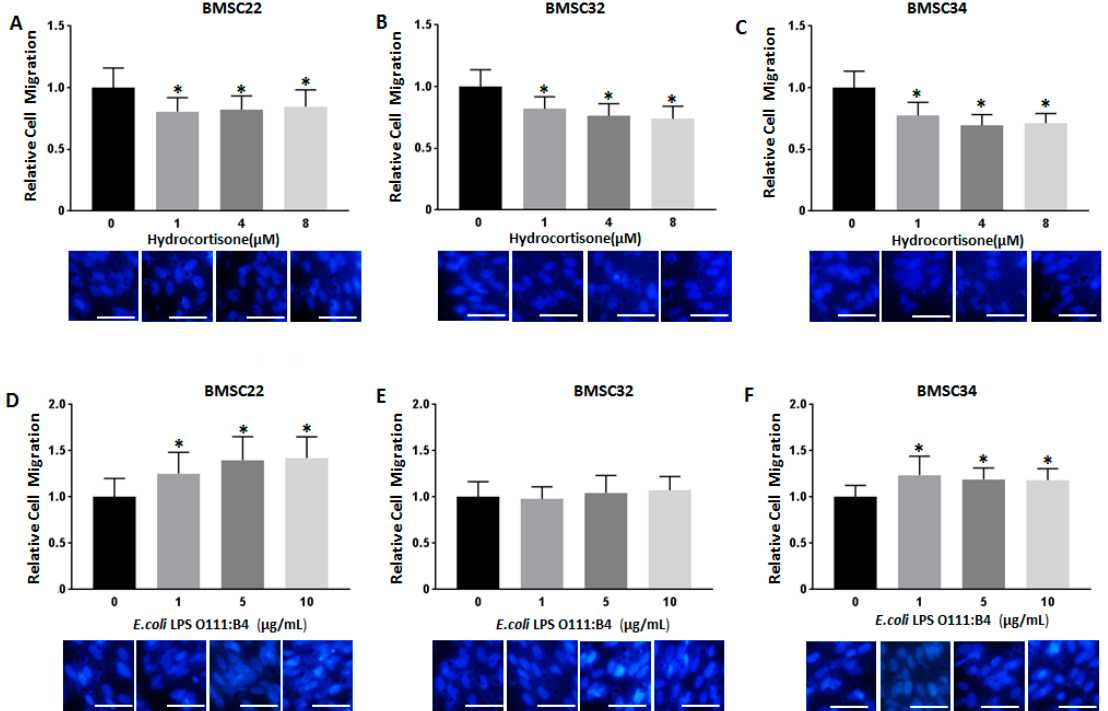
Figure 2. Stimulation with Hydrocortisone or E. coli O111:B4 regulates BMSC migration. The migration capacity of BMSC22, BMSC32 and BMSC34 in presence of Hydrocortisone ( A–C ) or LPS ( D–F ) was evaluated by Transwell Assays. BMSCs were seeded on top of Transwells, and after 24 h the cells that had migrated to the lower chamber were fixed, stained and quantified. Representative images of cells stained with DAPI are depicted below. (Scale bar is 50 µM, Magnification is 40×). * p < 0.05 versus 0 µM Hydrocortisone or 0 µg/mL LPS as determined by one-way ANOVA. 3.3. The Immunosuppressive Capacity of BMSCs is Regulated by Hydrocortisone and LPS from E. coli